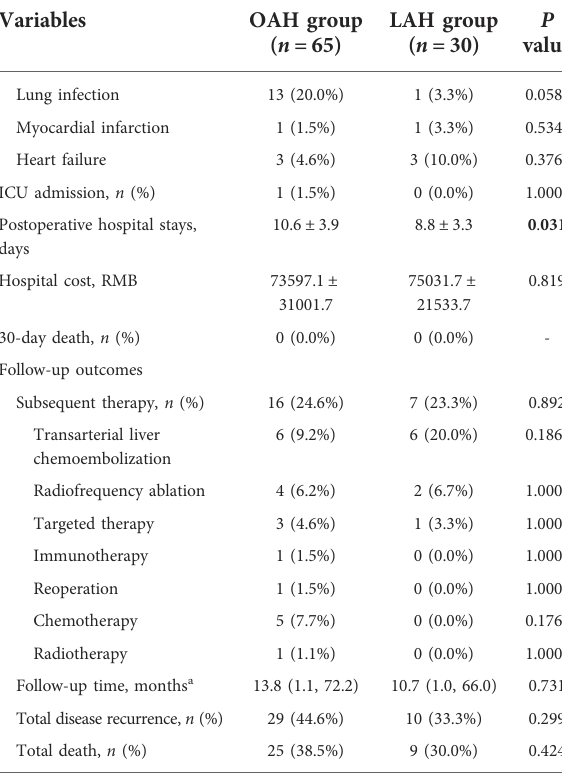
TABLE 3 Comparison of the surgical outcomes and follow-up outcomes between OAH and LAH